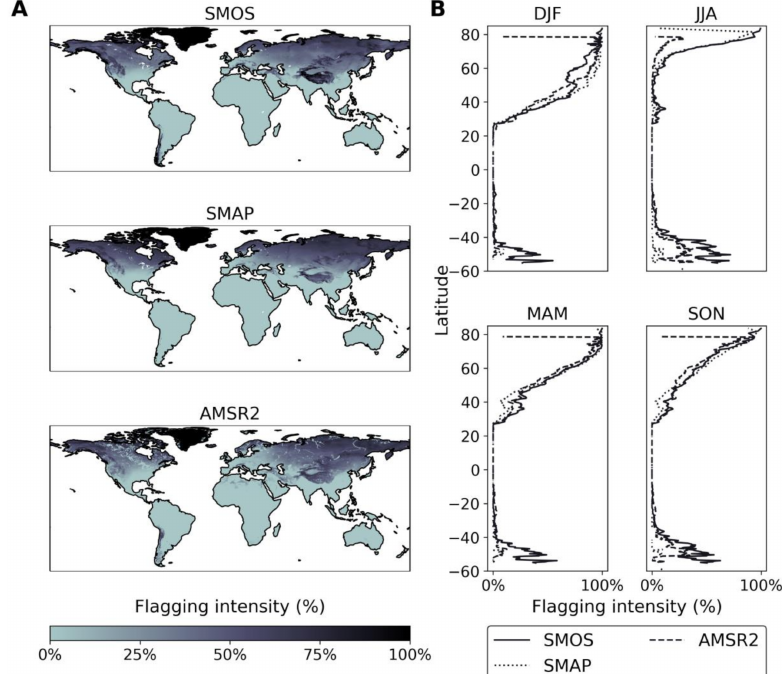
Figure 8. ( a ). Spatial maps of the percentage of observations flagged by snow / frozen flags averaged over the period 2016–2019 per dataset (left). ( b ). Latitudinal plots of the percentage of values flagged by snow / frozen flags over the period 2016–2019 per season in which the solid line represents the SMOS SM dataset, the dotted line represents the SMAP SM dataset, and the dashed line represents the AMSR2flag